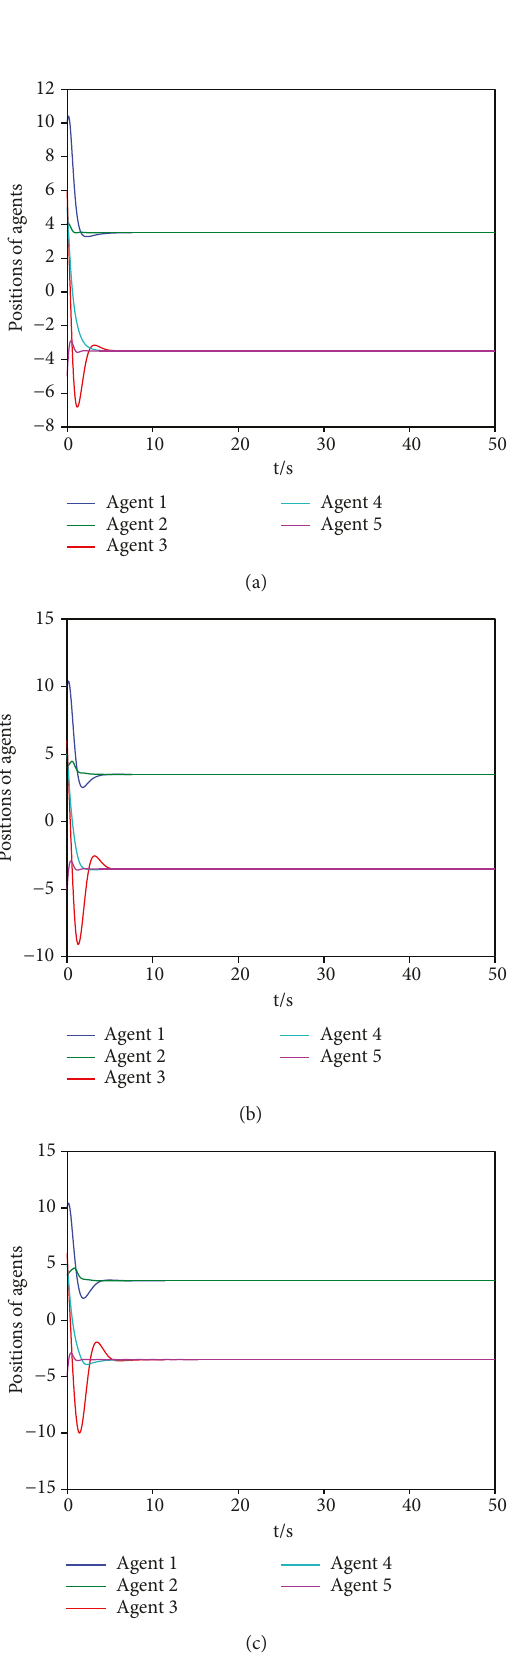
= 0 15 , τ = 0 2 , 1 2 = 0 , (b) τ = 0 5 , and (c) ij ij